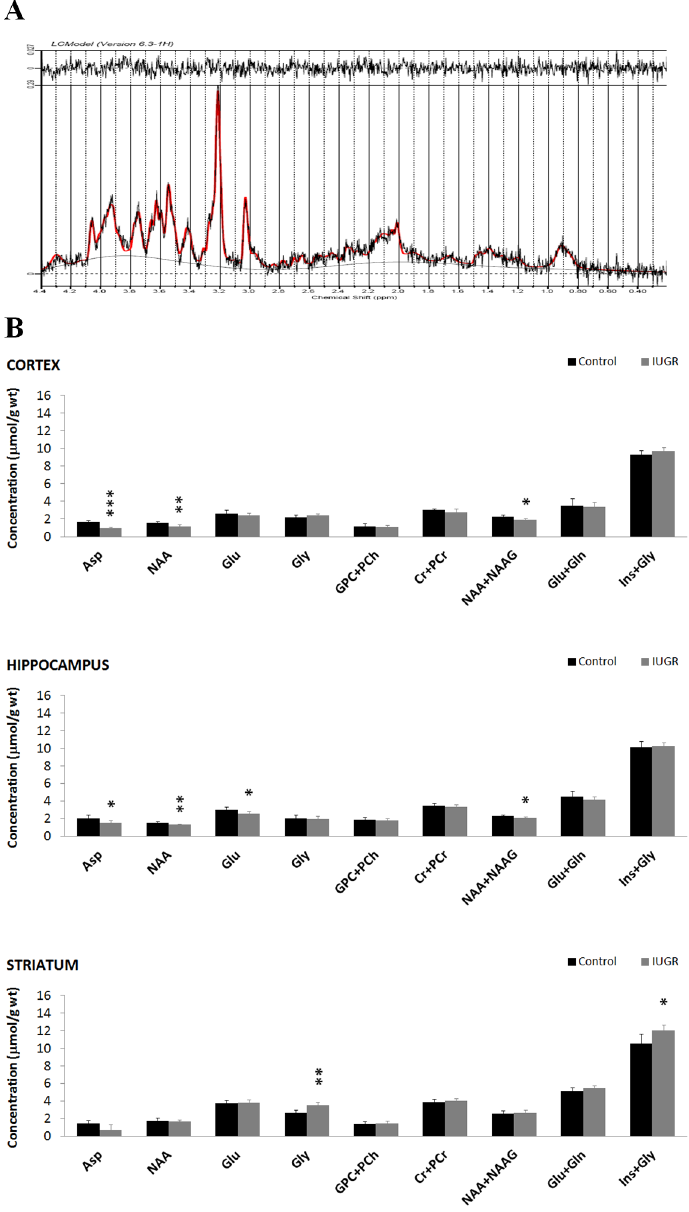
Fig 2. MRS quantifications. (A) Representative MRS profile of the hippocampus in a control animal (non- apodized spectrum, in black), with LCM baseline (grey line), fitting (red line), and residuals (top). (B) Selected metabolite levels in different brain regions: cortex (top), hippocampus (center), and striatum (bottom). Student´s t-Test: * p < 0.05; ** p < 0.01; *** p < 0.001. Aspartate (Asp); creatine (Cr); phosphocreatine (PCr); phosphorylcholine (PCh); glycero-phosphorylcholine (GPC); glutamate (Glu); glycine (Gly); myo-inositol (Ins); N-acetylaspartate (NAA); N-acetyl-aspartyl glutamate (NAAG).